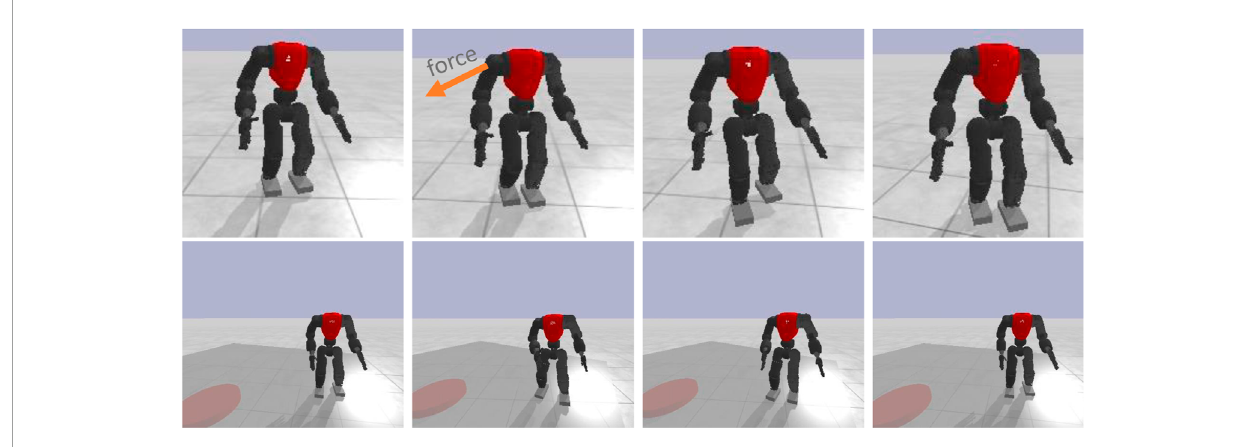
FIGURE 9 Trained neural network policies tested in other gaits: walking forward and walking in place on a rotating platform.